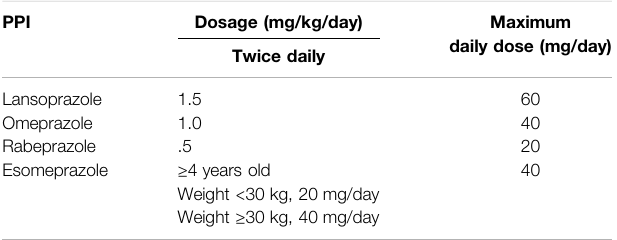
TABLE 1 | Dosage of PPIs used for Helicobacter pylori eradication therapy (Tolia et al., 2015). PPI Dosage (mg/kg/day)